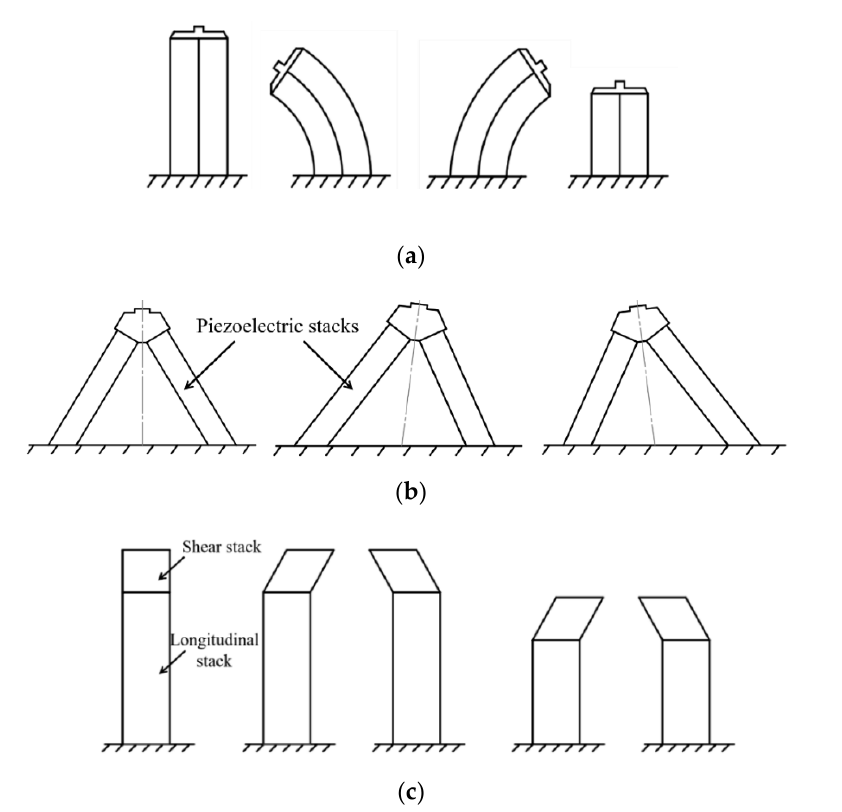
Figure 12. Designs of walking legs: ( a ) bimorph configuration; ( b ) V-shape configuration; ( c ) combination of longitudinal and shear modes of piezoelectric. Table 5. Comparison of the output force and speed performance of three commercial designs using the walking mechanism.